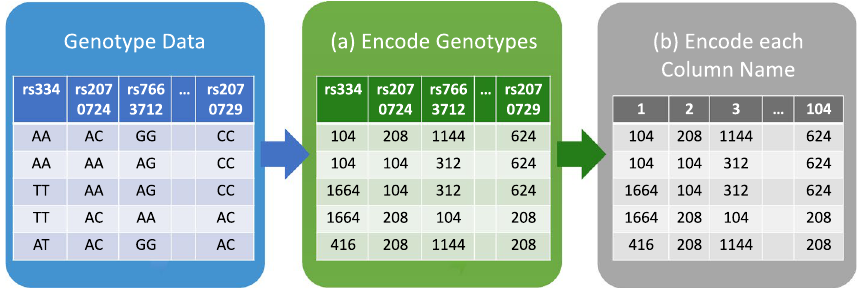
Fig. 2 Overview of steps to encode genotypes and column names for the proposed wGRS